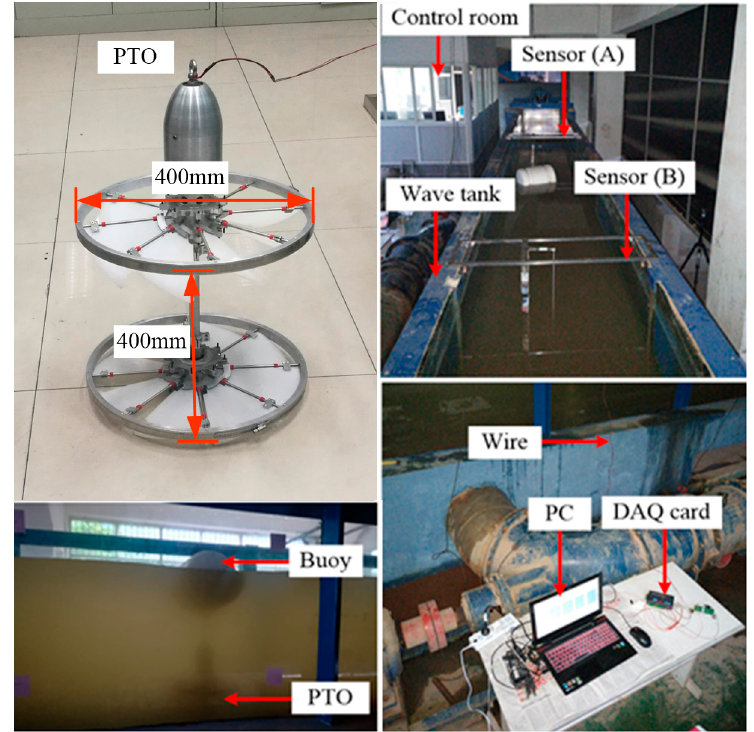
Figure 10. Experimental platform in a wave tank.